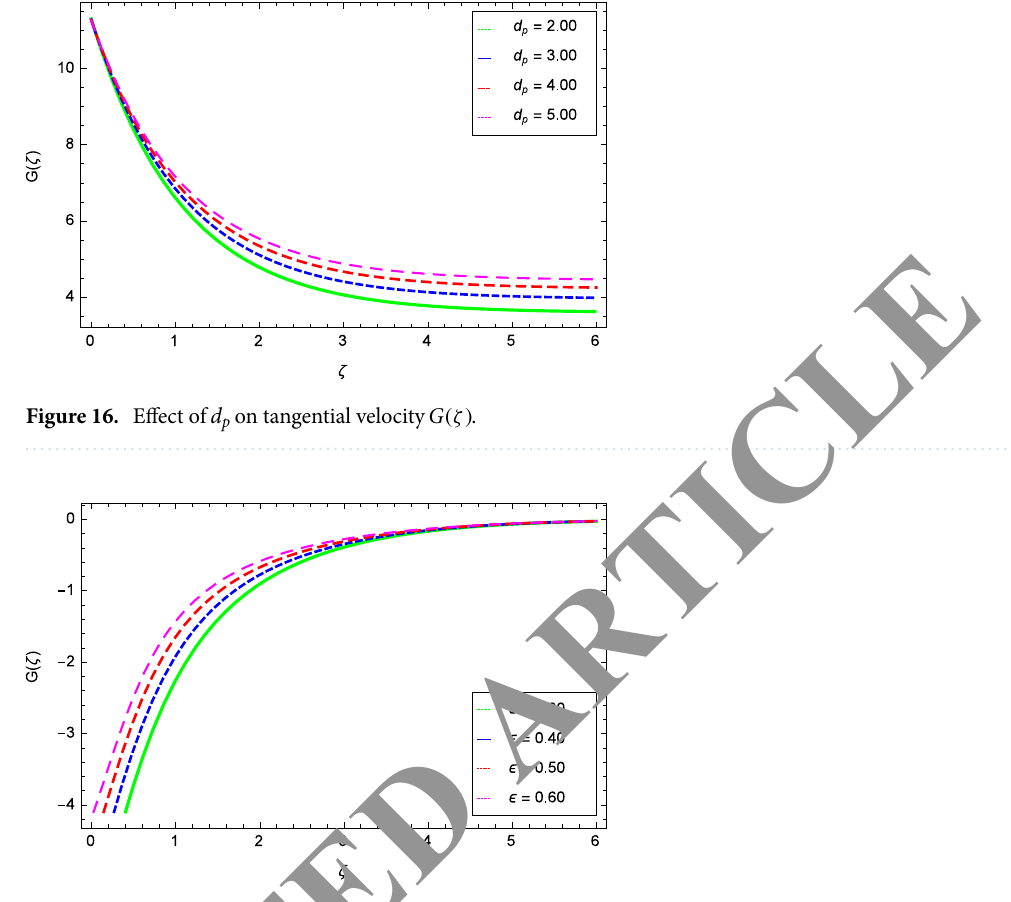
Figure 17. Effect of ǫ on tangential velocity G (ζ) .